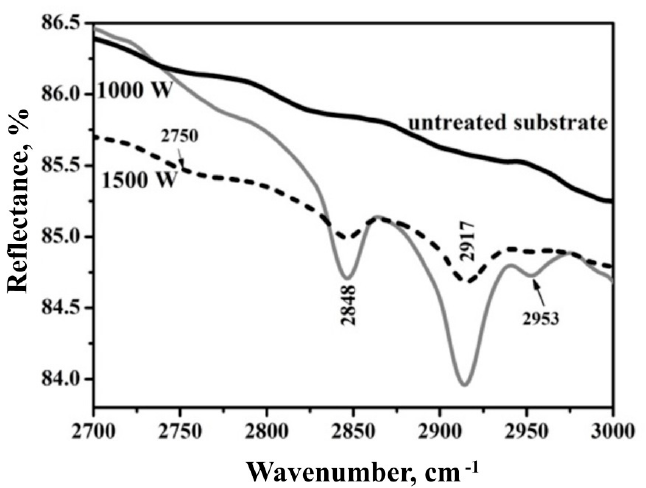
Figure 3. FTIR spectra of DLC films obtained on untreated substrates and electron-beam-treated substrates in the spectral range of 2700–3000 cm − 1 . substrates in the spectral range of 2700–3000 cm − 1